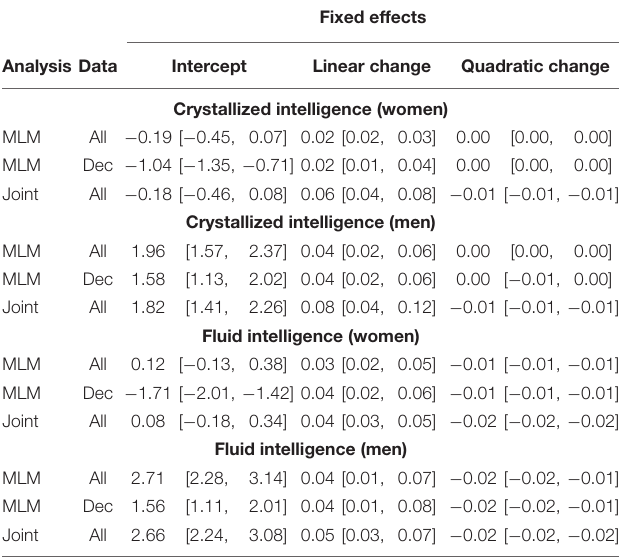
TABLE 3 | Fixed effects from quadratic change models